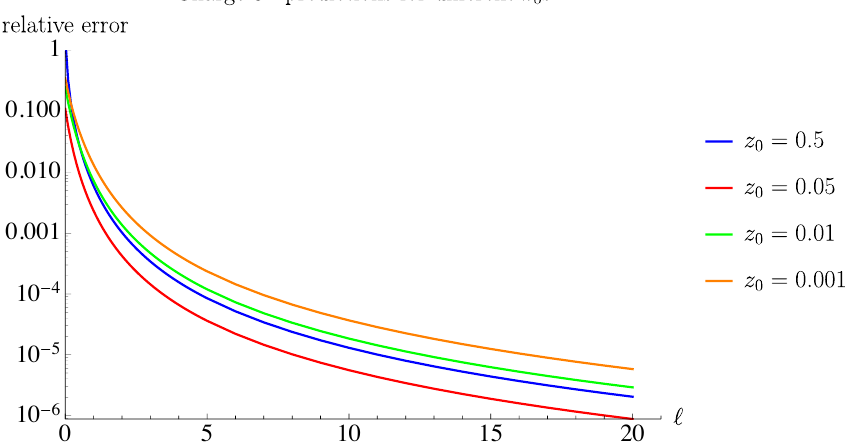
Figure 22 . A comparison between using di(cid:11)erent values of z 0 in the charge 0 + sector. We evaluate the relative error by